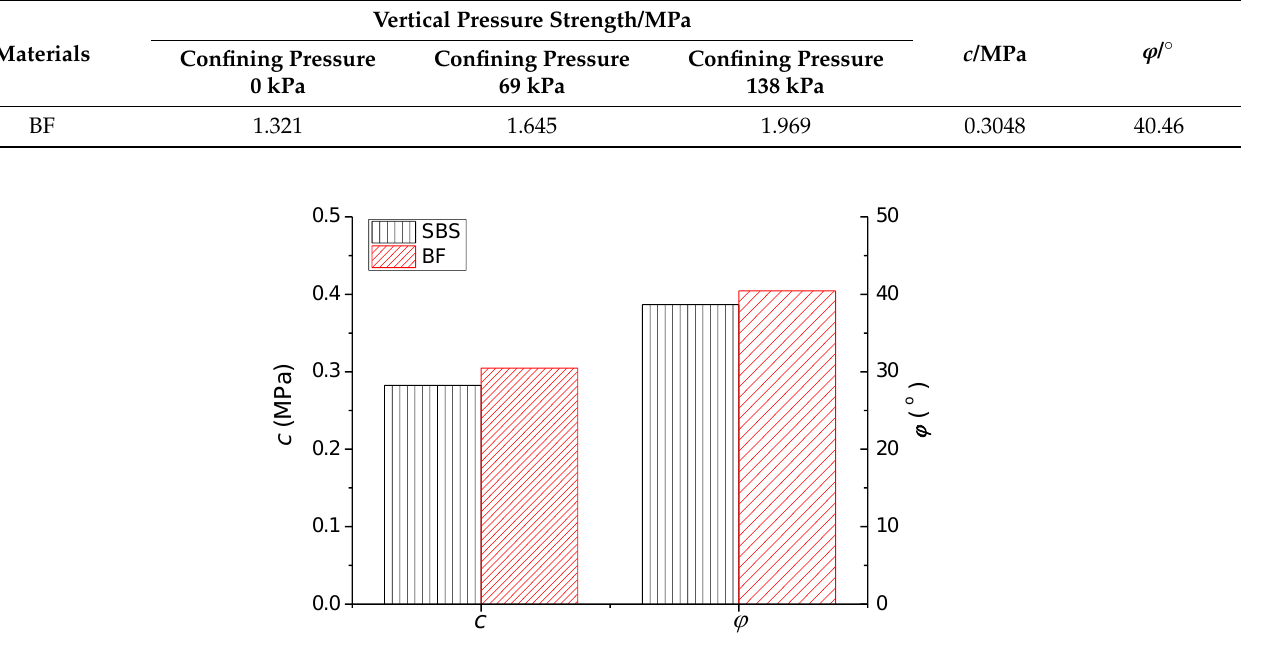
Figure 7. Comparison results of the shear parameters with and without fiber mixture.